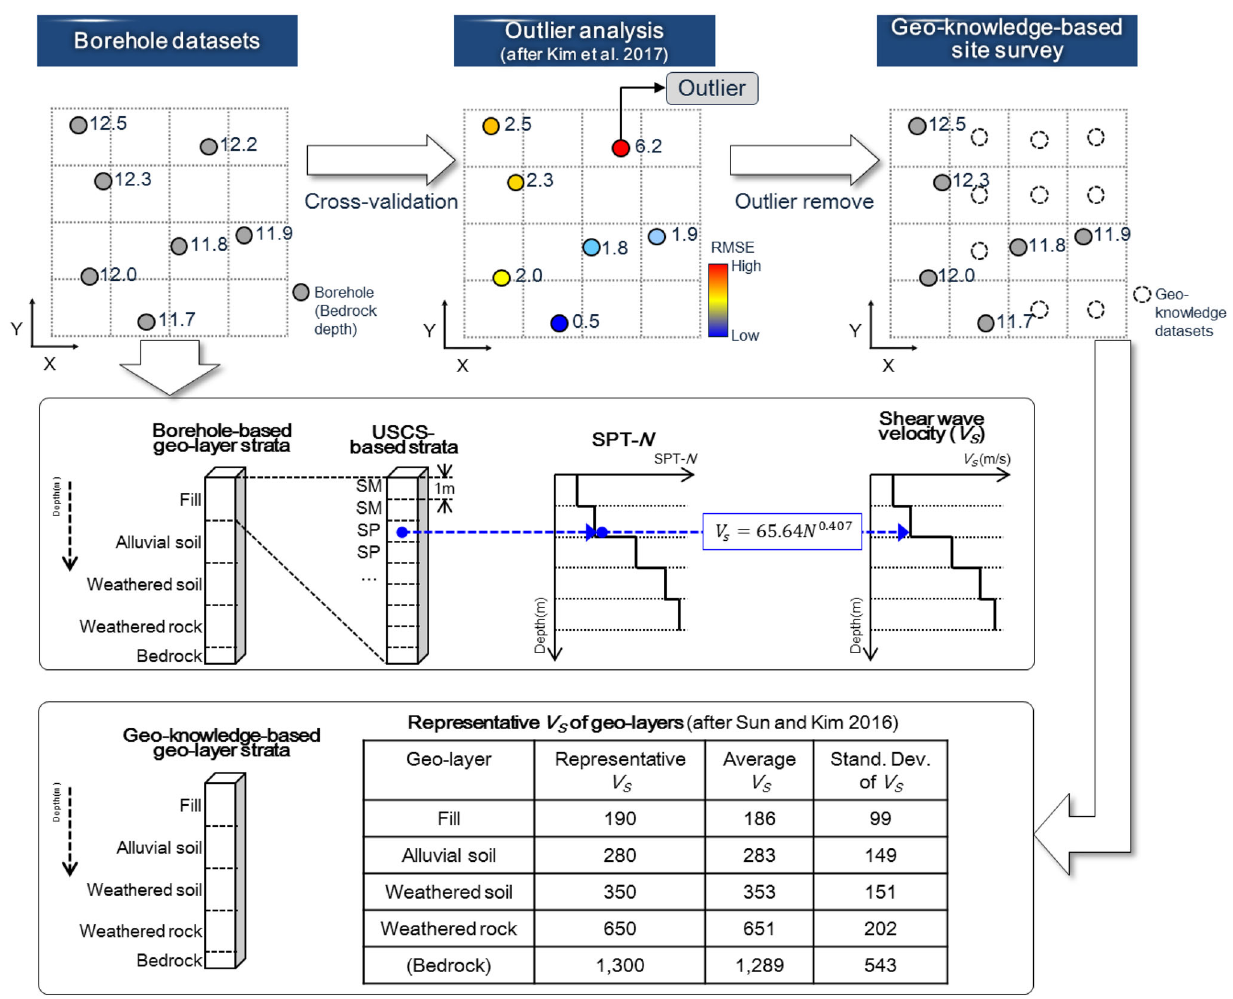
Fig. 2 Conceptual procedure for outlier analysis and geo-knowlege-based site survey to construct geo-layer and V S profiles. USCS Unified Soil Classification System; SPT-N standard penetration test N